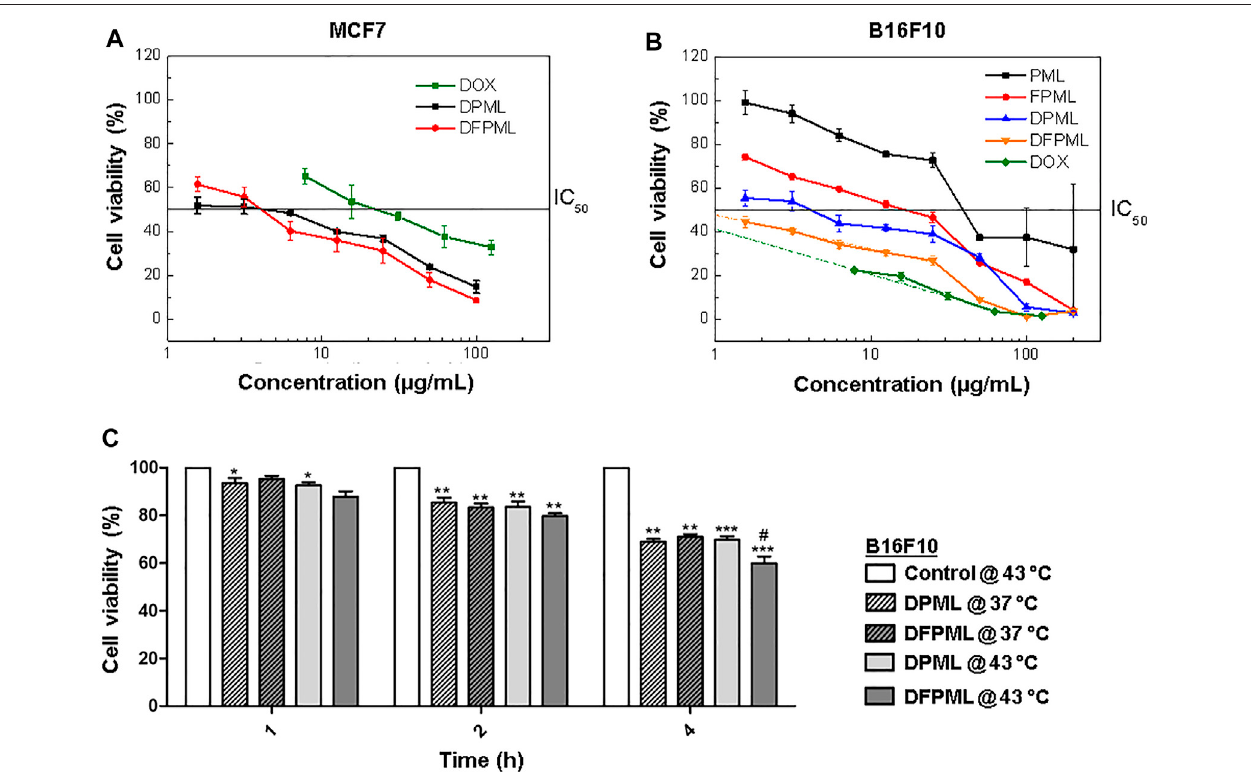
FIGURE 4 | Conventional and temperature-mediated DOX release for cytotoxic activity. Cell viability as a function of nanocarrier concentration and IC 50 determinationforboth (A) MCF7humanmammaryadenocarcinomaand (B) B16F10murinemelanomacellsexposedtodifferentcontrol(DOX,PML,FPML,andDPML) and DFPML formulations. (C) Temperature-induced cytotoxicity of DPML and DFPML incubated with B16F10 cells under either 37 ° C (normothermia) or 43 ° C (hyperthermia).